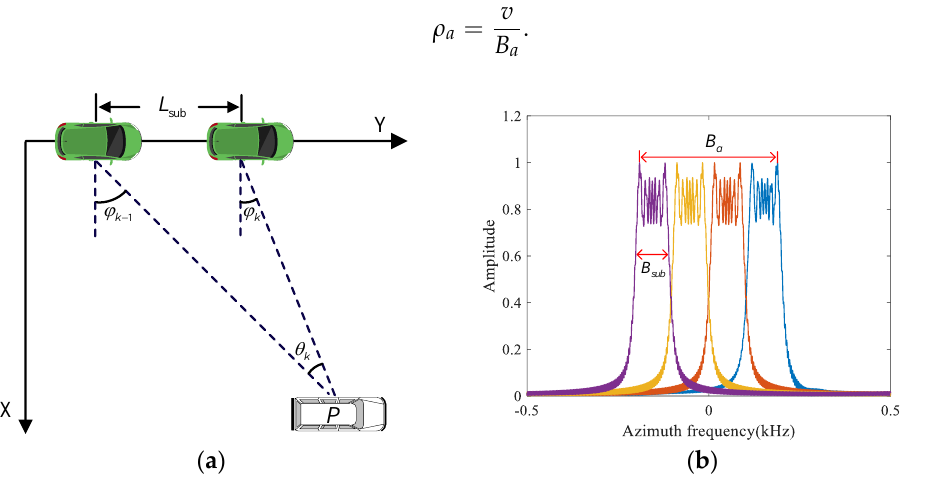
Figure 6. Instantaneous Doppler frequency of a single-point target. ( a ) Coherent accumulation angle of sub-aperture; ( b ) Instantaneous Doppler bandwidth of sub-aperture.